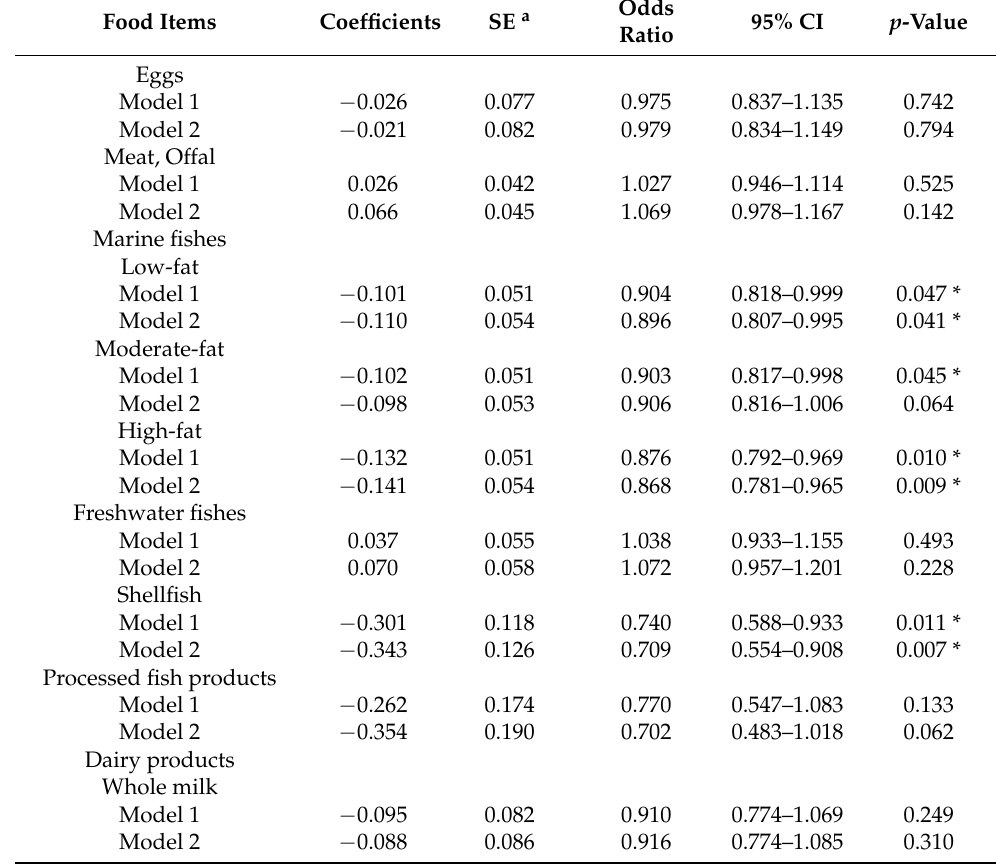
Table 3. Associations between consumption of selected foods and diabetic